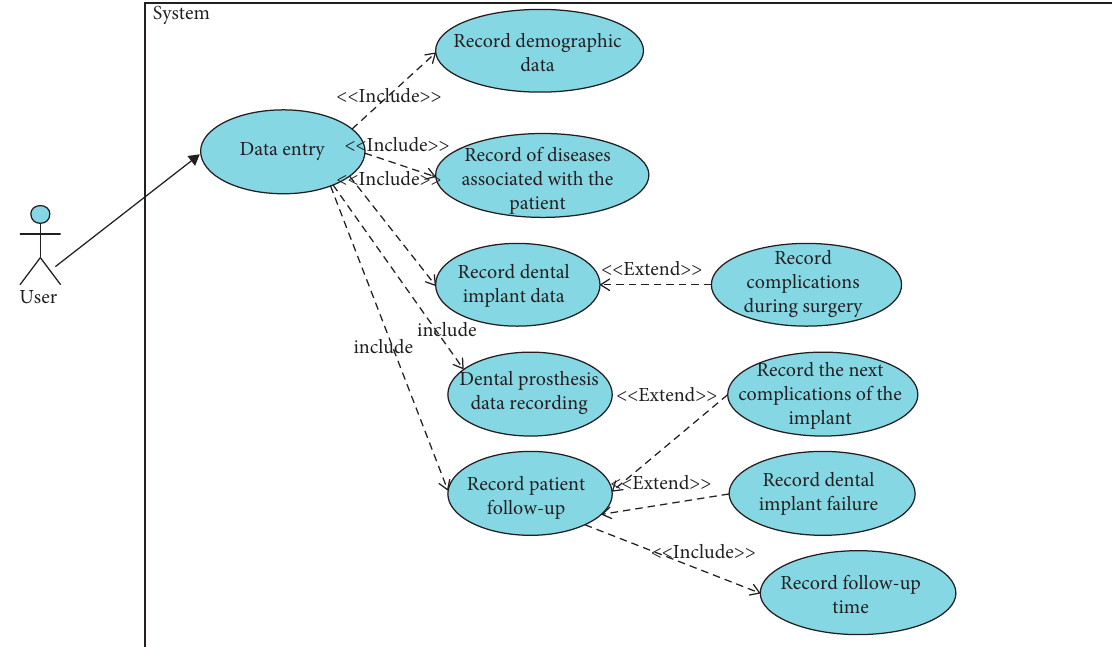
Figure 1: Diagram used to record data in the